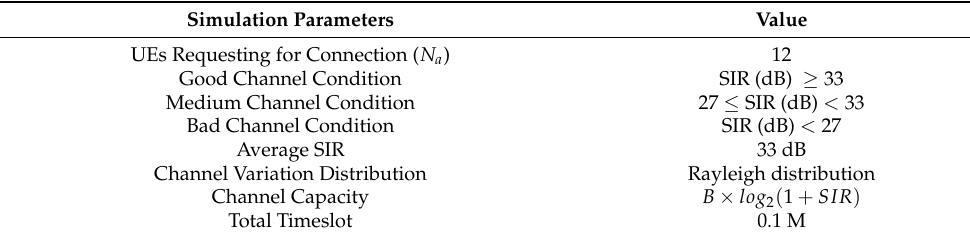
Table 1. Simulation parameters for generating dataset.